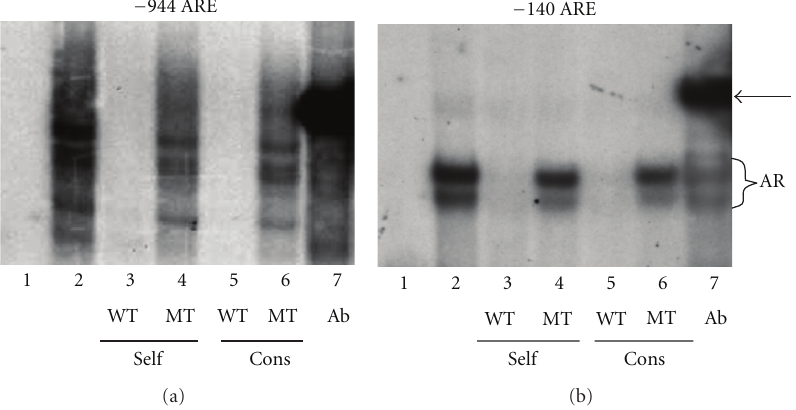
Figure 5: The AREs in tcf8 bind AR. PC-3/AR cells were treated with 5 nM DHT for 24hrs, and nuclear protein extracts prepared . Oligomers corresponding to the regions of DNA containing (a) the − 944 ARE and (b) the − 140 ARE were radiolabeled and used as probes. Both GMSAs were run in parallel, with only the ARE probe di ff ering. Ten μ g of nuclear protein was used in each lane except for Lane 1, which contained only the radioactive oligomer. Lane 2: plus nuclear extract. Lane 3: plus 50x cold wild-type (WT) self-competitor. Lane 4: plus 50x cold self-competitor with a mutated (MT) ARE. Lane 5: plus 50x cold WT consensus ARE. Lane 6: plus 50x cold MT consensus ARE. Lane 7: plus an AR antibody. The arrow indicates the band representing the AR/DNA complexes supershifted by the antibody.